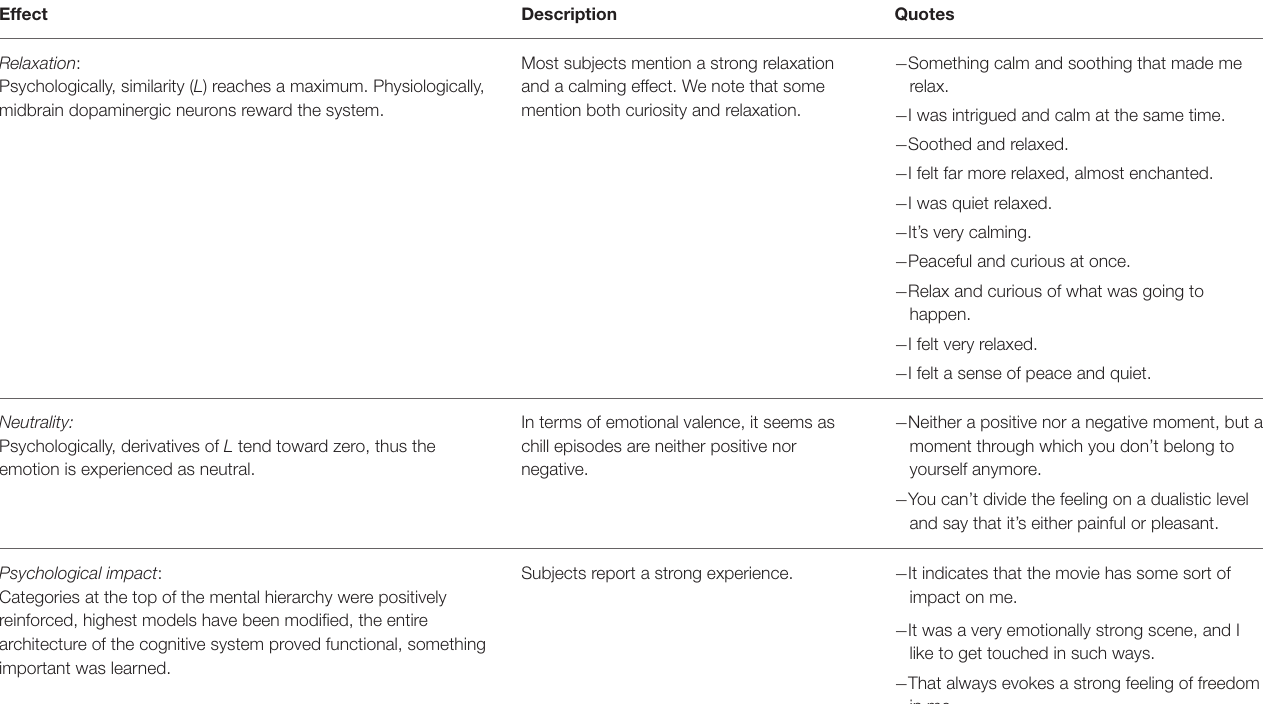
TABLE 3 | Phenomenology of chill episodes. Effect